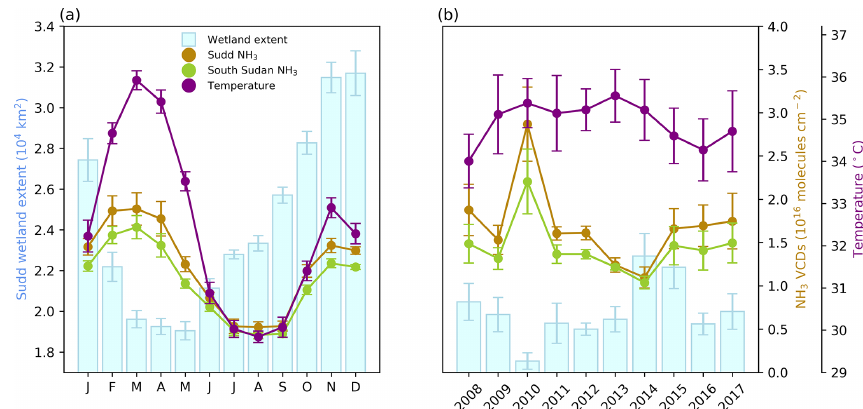
Figure 5. Mean (a) monthly and (b) February through May annual mean flooded extent of the Sudd, surface temperatures over South Sudan, and NH 3 VCDs over the Sudd and the entirety of South Sudan for the period 2008 through 2017.